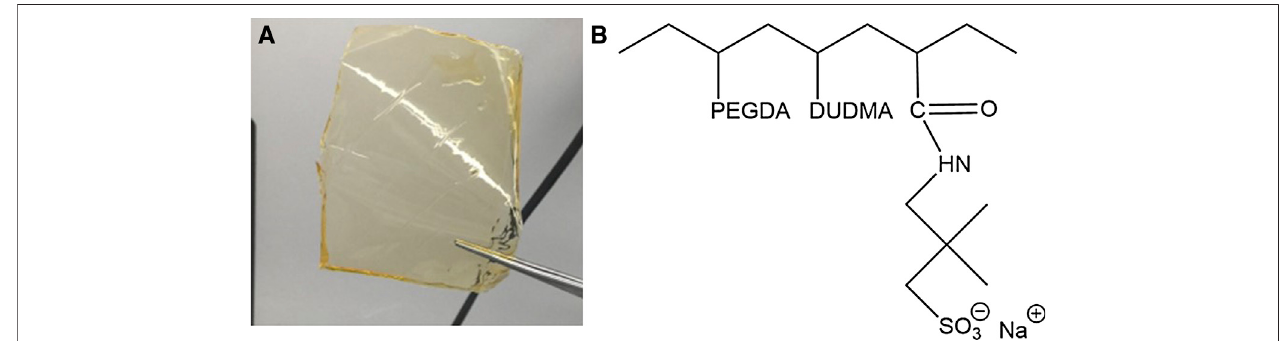
FIGURE2|(A) Free-standingNa + gelpolymerelectrolytemembraneuponcompletionofUV-curing. (B) Chemicalstructureofphotopolymerizednon-solvatedNa + gel polymer